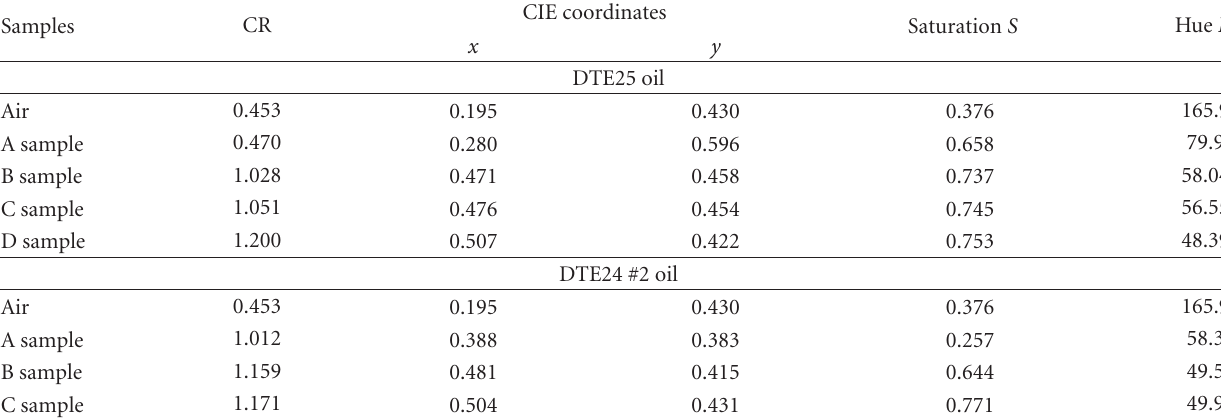
Table 1: Comparison of CR with conventional chromatic parameters—saturation S , Hue H , CIE—chromaticity ( x - y ) coordinates, for fresh (A sample) and in-service degraded (B sample and C sample) oils.